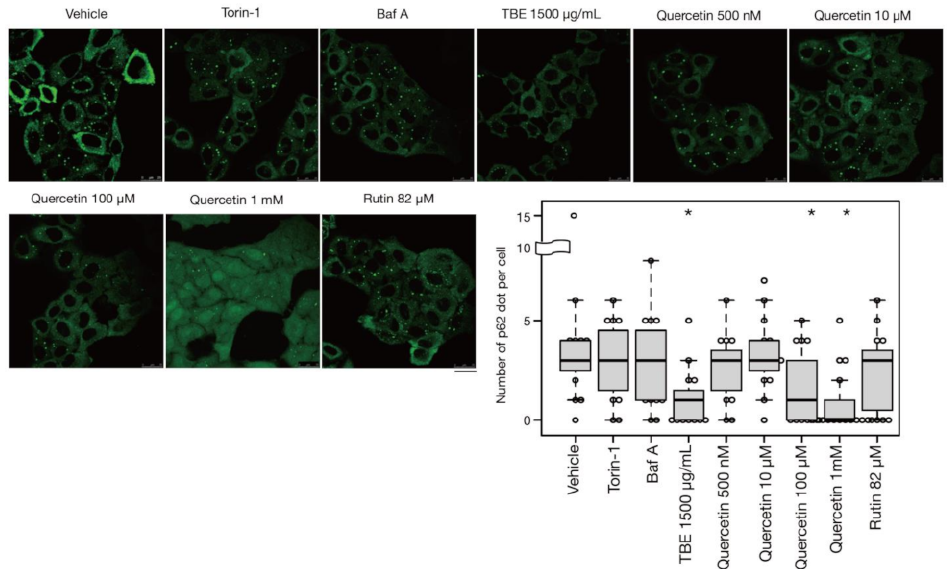
Figure 5. TBE and quercetin enhance the induction of aggrephagy. HeLa cells were treated with puromycin for 4 h, Figure 1. Bafilomycin A1, TBE, quercetin, or rutin at the indicated concentrations for 1 h. p62 was detected by immunostaining. The graph shows the number of p62 dots over 1.4 µ m in diameter per HeLa cell. Bar: 25 µ m. Median: line; upper and lower quartiles: boxes; 1.5 interquartile range: whiskers. * denotes p < 0.05 by unpaired two-tailed Student’s t